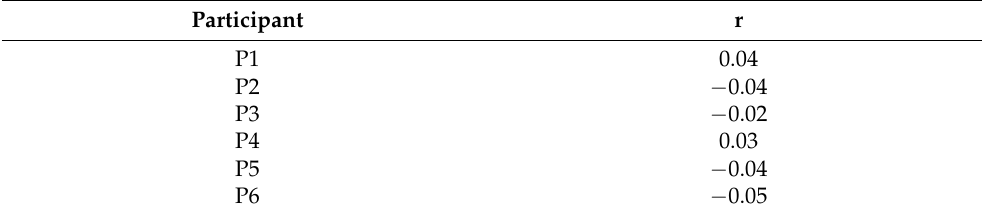
Table 6. Correlation summary ( − 1 ≤ r ≤ 1).